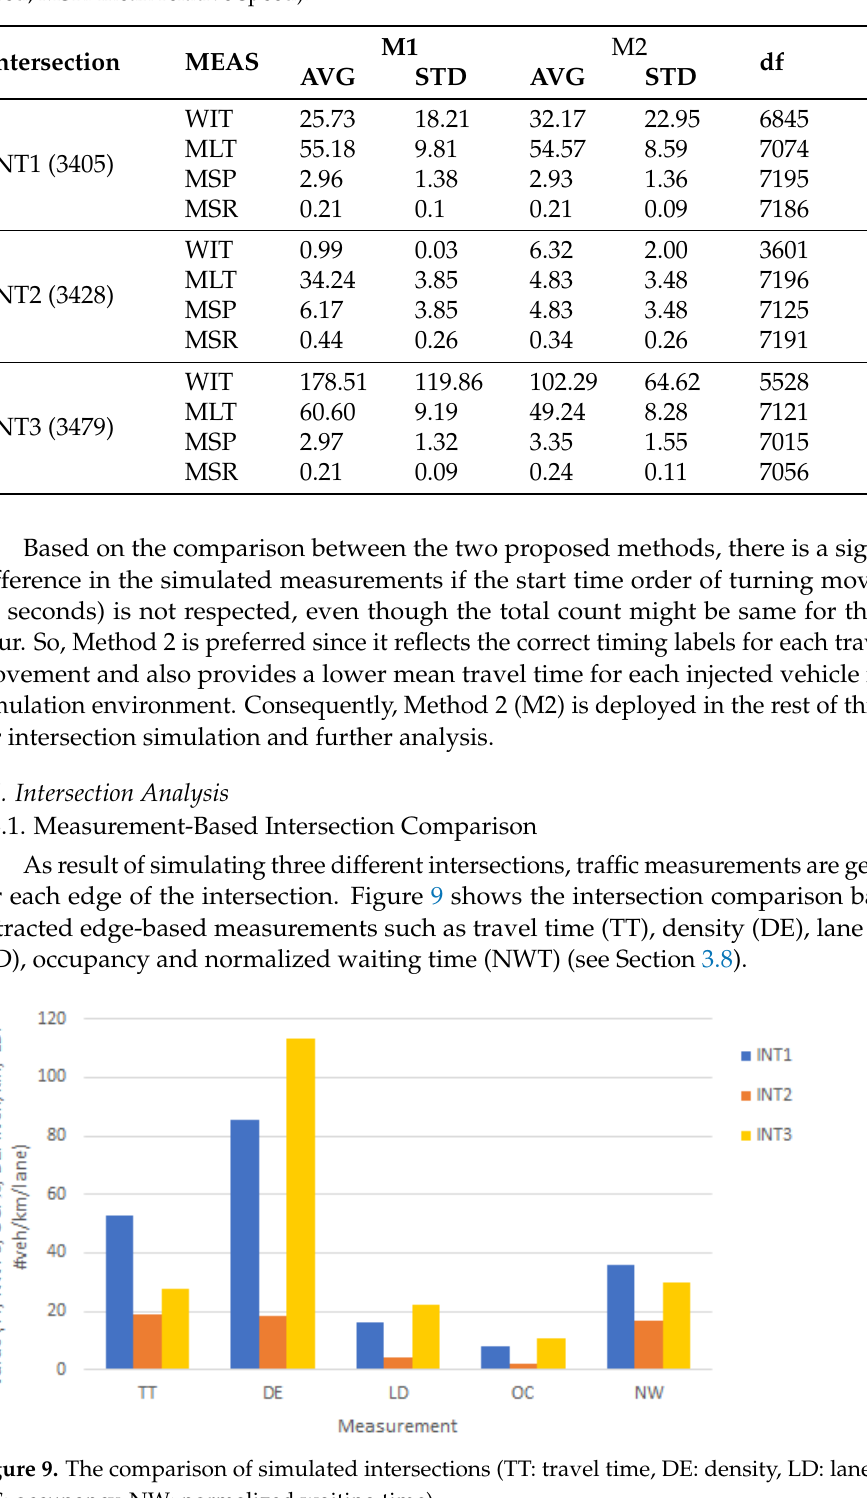
Table 3. Means and standard deviations of the simulation measurements. (MEAS: measurement, M1: Method 1, M2, Method 2, WIT: wait to insertion time, MLT: mean latest travel time, MSP: mean speed, MSR: mean relative speed).